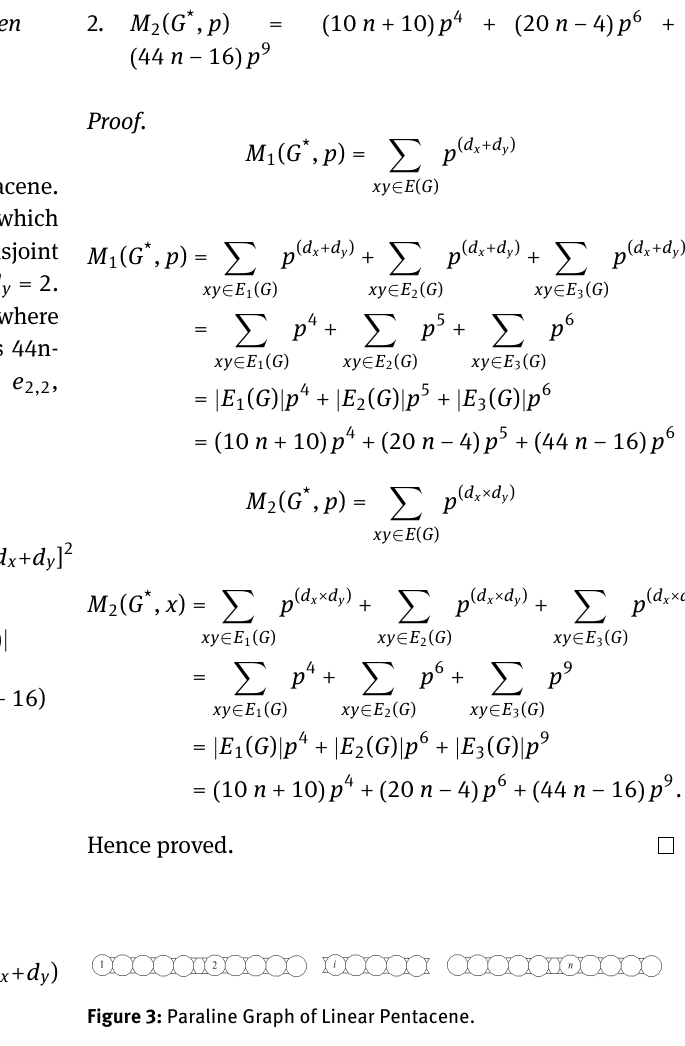
Figure 3: Paraline Graph of Linear